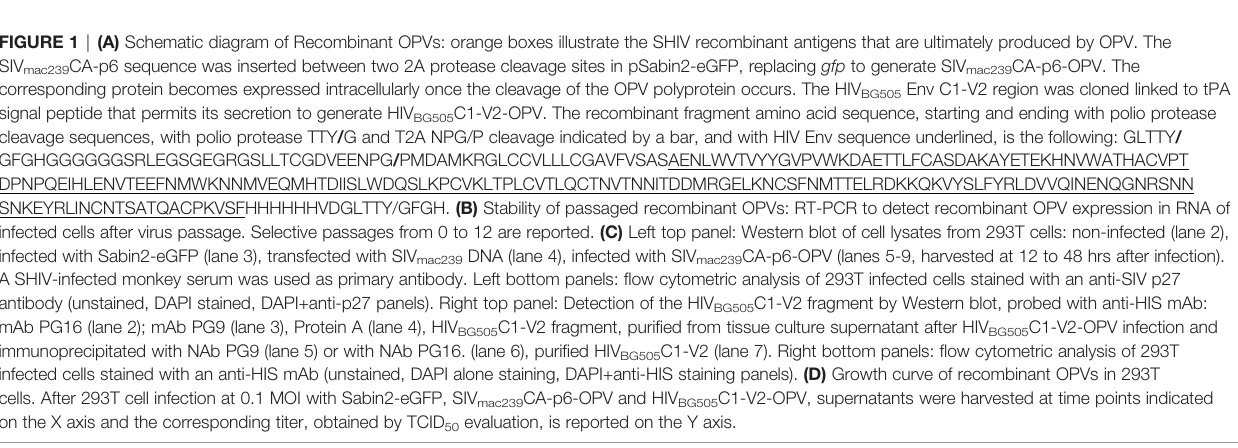
Anti-Human Immunode fi ciency Virus (HIV)-1 gp120 Monoclonal Antibody (PG16), cat. # ARP-12150, also contributed by IAVI (64).